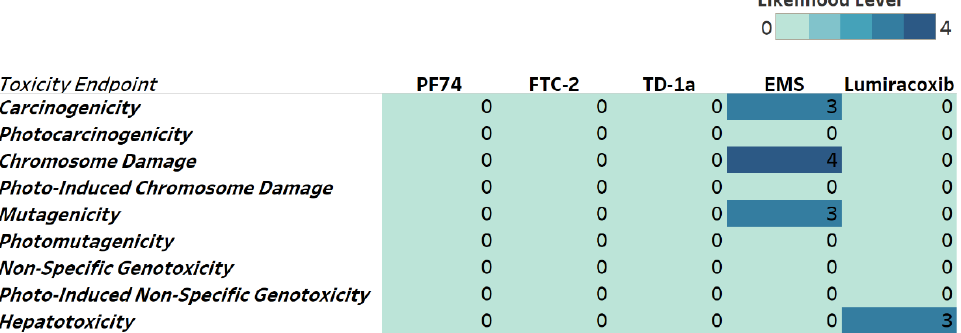
Figure 7. Genotoxicity and hepatotoxicity endpoints for selected compounds. The highlighted table shows the StarDrop V7 (Optibrium, Ltd., Cambridge, UK)–derived toxicity endpoints using the Derek Nexus module based on a knowledge-based prediction. Structural alerts within the molecule with a level of likelihood for concerns are based on precedence from experimental data. Likelihood level 0 = No report; 1 = Inactive; 2 = Equivocal; 3 = Plausible; 4 = Probable. Ethyl methanesulfonate (EMS) was used as a positive control for genotoxicity [47], and Lumiracoxib [48] as a positive control for hepatotoxicity endpoints.